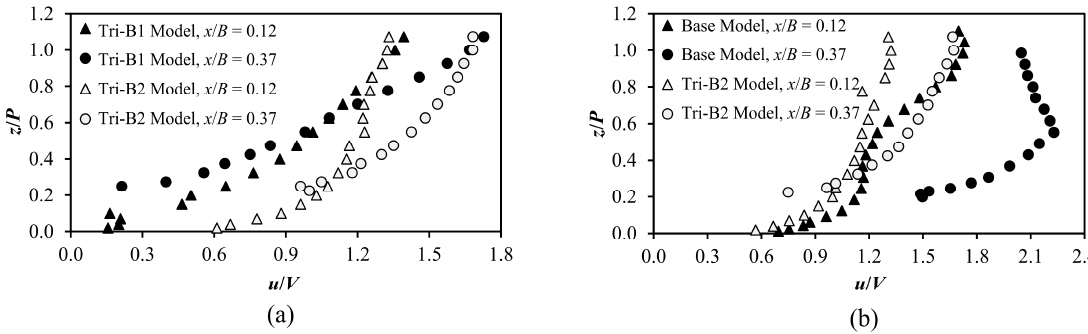
Figure 9. Dimensionless velocity profiles in the inlet key centerline: ( a ) H o / P = 0.5 ( V = 0.337 and 0.454 m/s at the Tri-B1 and Tri-B2 models, respectively); ( b ) H o / P = 0.2 ( V = 0.293 and 0.197 m/s at the base and Tri-B2 models, respectively).